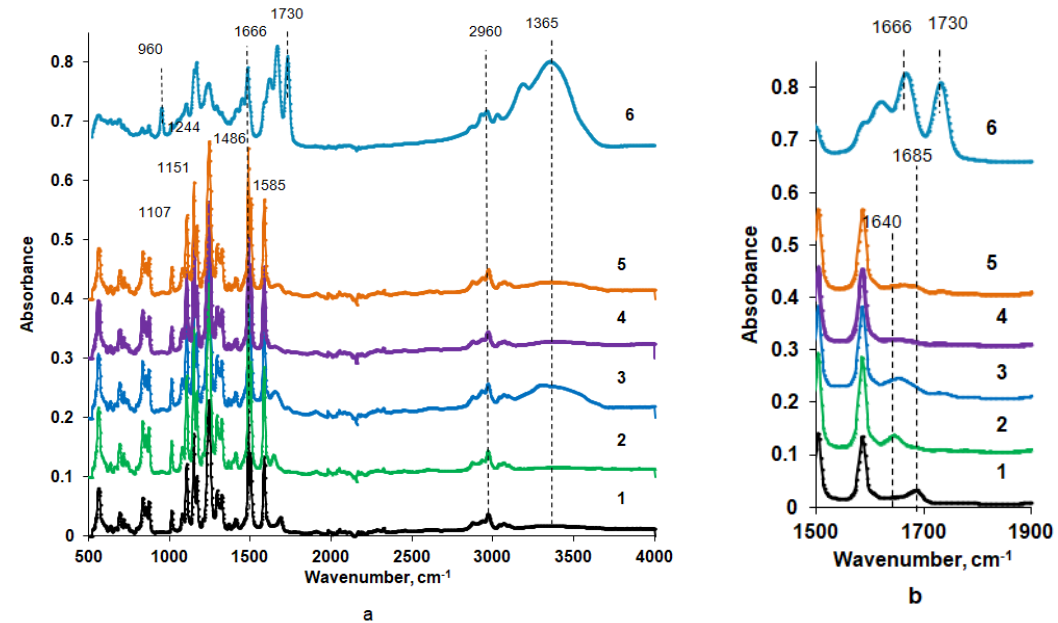
Figure 5. Fourier transform infrared spectroscopy (FTIR) spectrum ( a ) and fragment of the spectrum ( b ) of the polysulfone (PSF) membrane selective (1–3 and 5) and bottom (4) layer; Praestol 859 in a coagulation bath, wt.%: 1—0, T = 60 ◦ C (PSF60); 2—0.2, T = 60 ◦ C (B-0.2-60); 3—0.3, T = 60 ◦ C (B-0.3-60); 4—0.3, T = 60 ◦ C (B-0.3-60), bottom layer; 5—0.3; T = 25 ◦ C (B-0.3-25); 6—Praestol 859 powder.